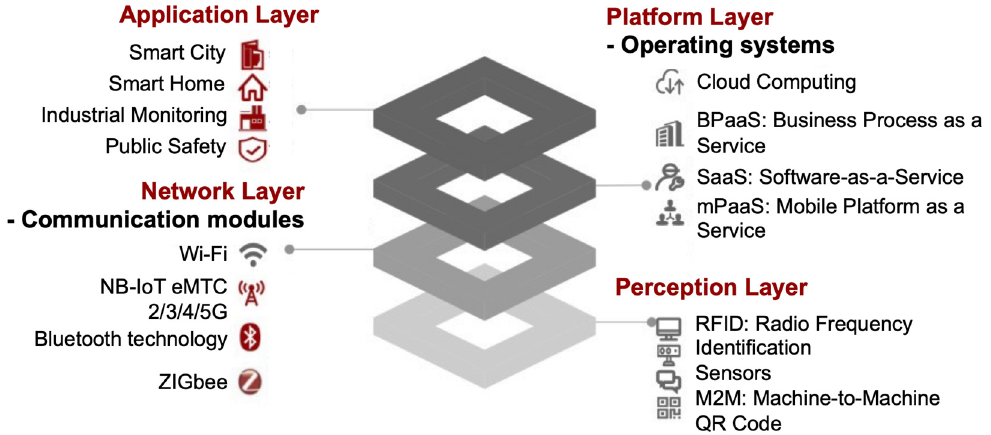
Figure 1. Architecture of Internet of Thing (IoT).